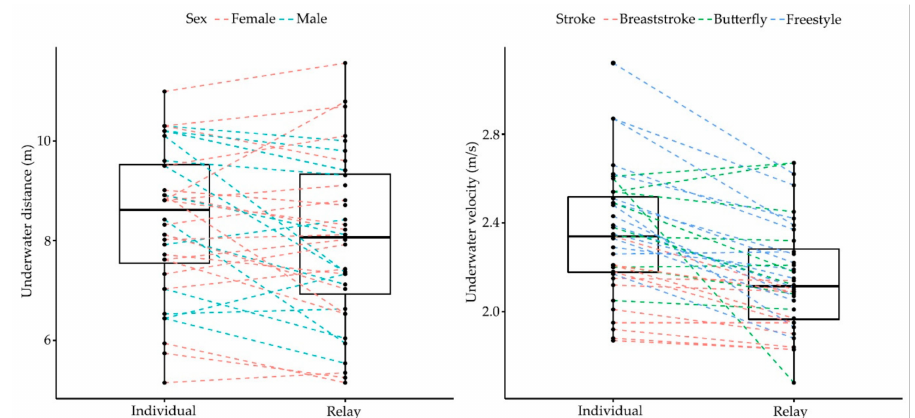
Figure 2. Individual and group variation in the underwater start phase between individual and relay events of the LEN European Junior Swimming Championships. Different stroke and gender groups are represented by colours.